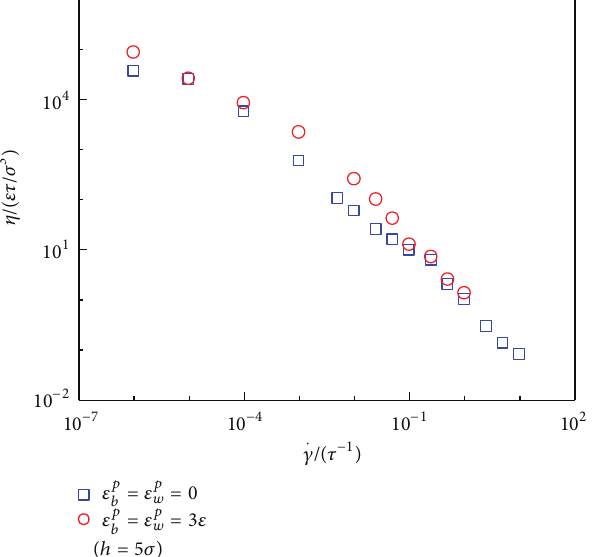
Figure 33: The shear viscosity of nonfunctional PFPE ( 𝜀 𝑝 𝑏 = 𝜀 𝑝 𝑤 = 0 ) nanofilmswiththreedifferentwallseparations( ℎ = 3𝜎 , 5𝜎 ,and 10𝜎 ) as a function of shear rate.